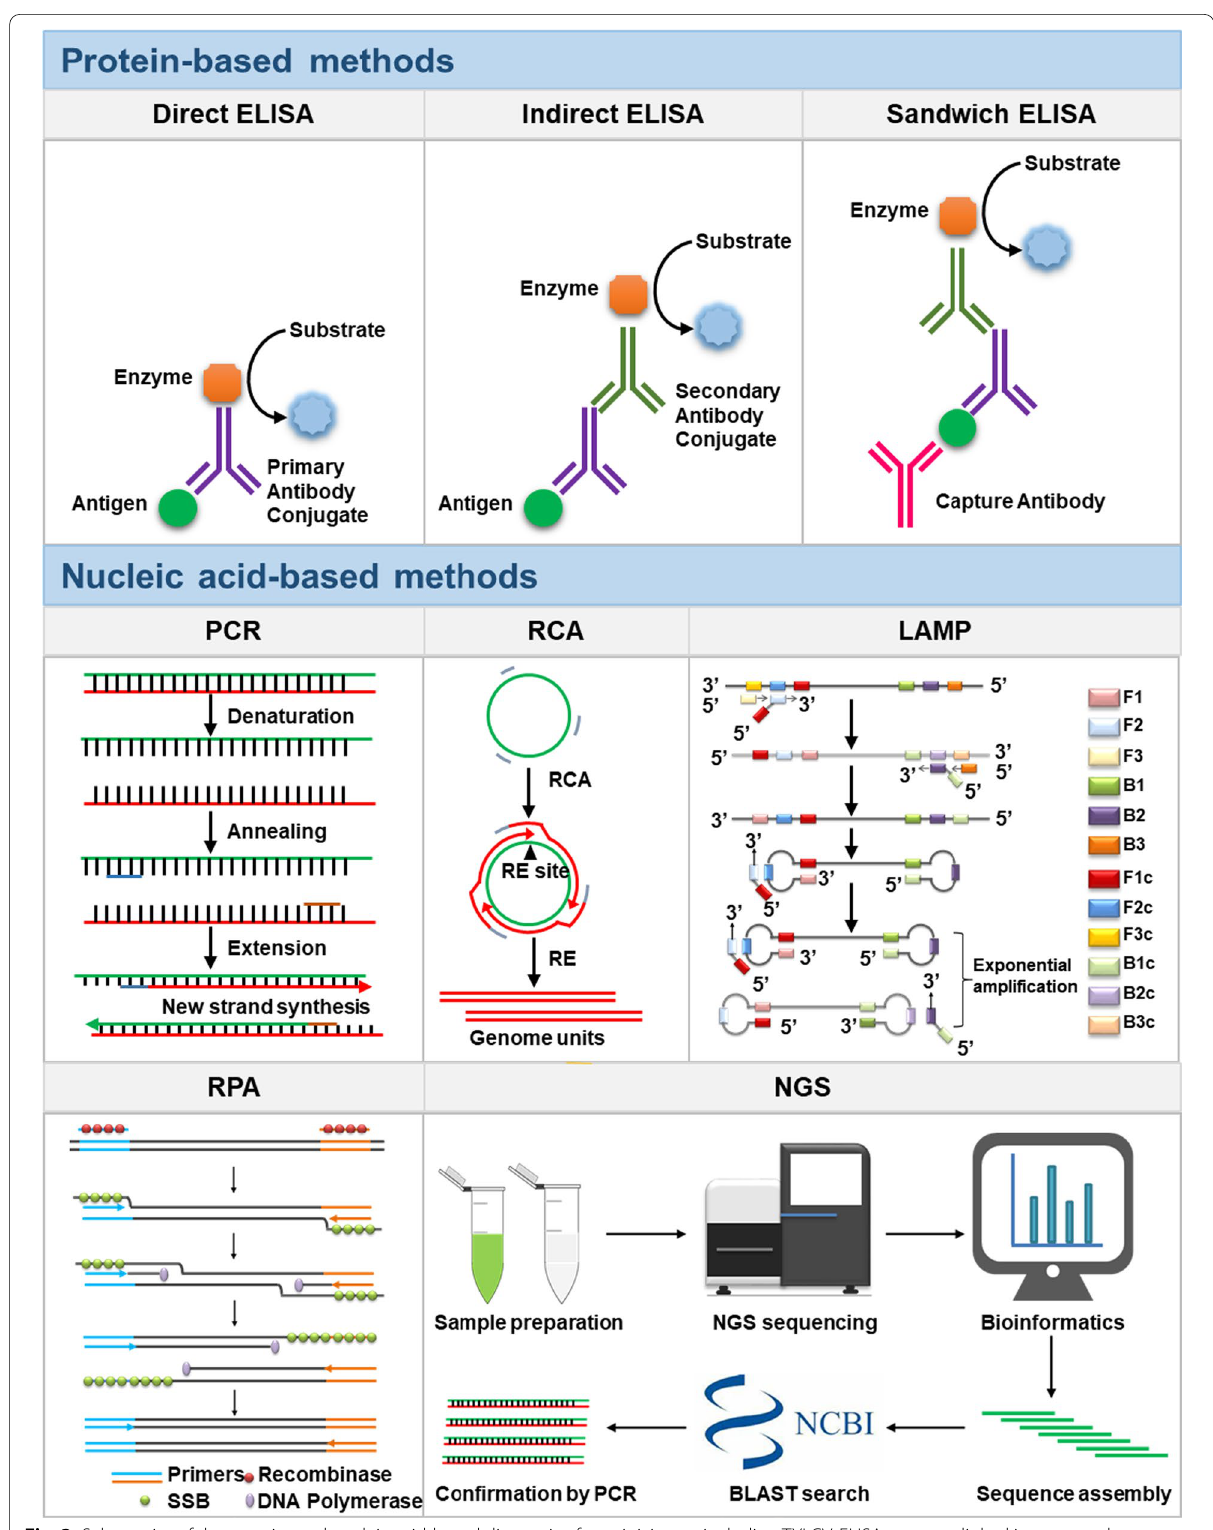
Fig. 3 Schematics of the protein- and nucleic acid-based diagnosis of geminiviruses, including TYLCV. ELISA, enzyme-linked immunosorbent assay; PCR, polymerase chain reaction; RCA, rolling circle amplification; LAMP, loop-mediated isothermal amplification; RPA, recombinase polymerase amplification; NGS, next-generation